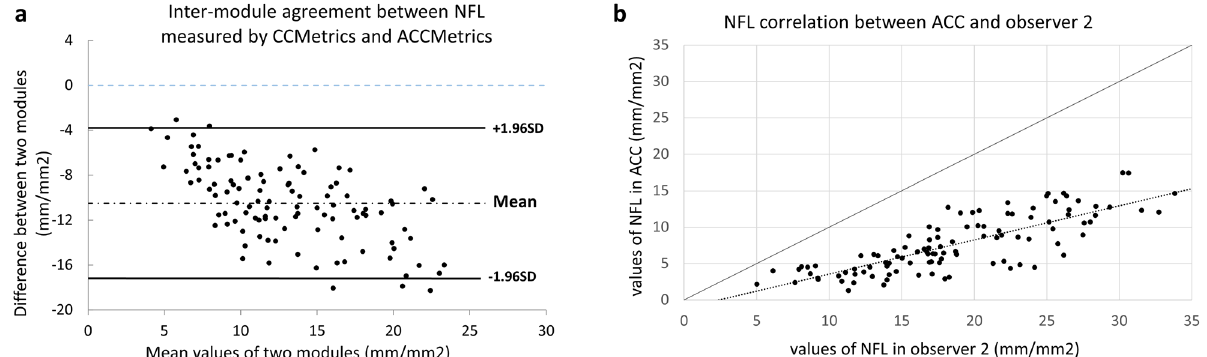
Figure 2. Agreement plot (a) and comparison plot (b) of nerve fiber length (NFL) between observer 2, the observer with the highest intra-observer repeatability in the original group, and ACCMetrics (ACCM). In (a) , the black dotted line represents the mean differences, and the solid lines represent the 95% limits of agreement. The blue dashed line represents no difference between NFL measured by two different modules. In (b) , linear regression was depicted in the dotted line and equivalence line was depicted in the solid line. Correlation was excellent between observer 2 and ACCM but there was a significant underestimation using ACCM to calculate NFL comparing with using manual CCMetrics